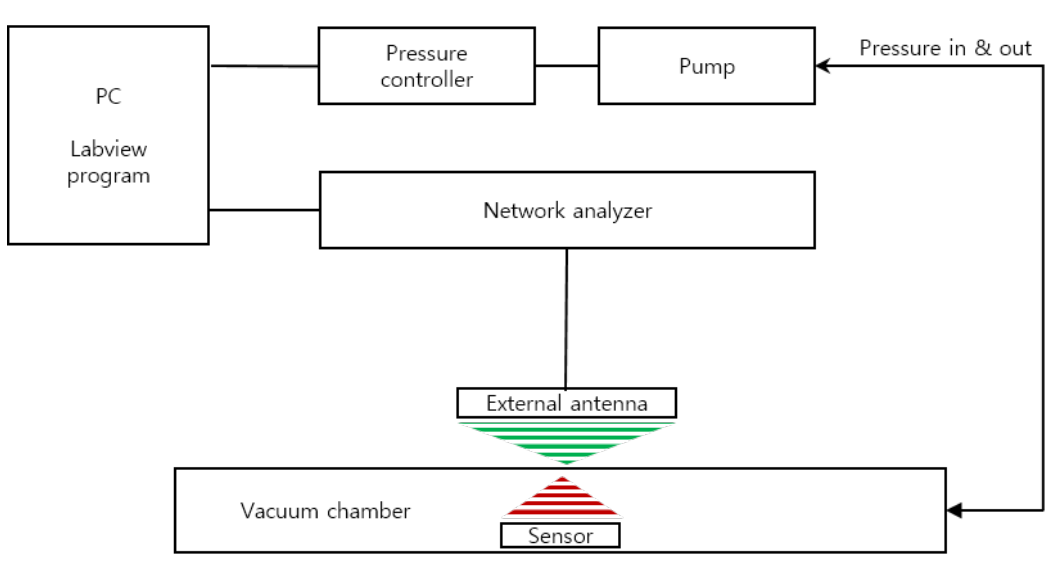
Figure 3. Schematic of the sensor characterization evaluation system.